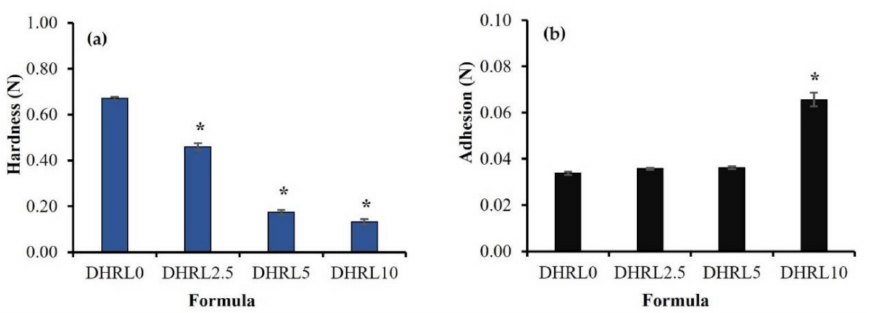
Figure 4. Mechanical properties of oil/rosin in situ forming gel after gel formation at three days: ( a ) hardness of gel, ( b ) adhesion of gel (n = 3). * Significant difference, p <